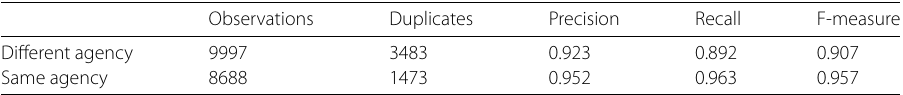
Table 5 Assessment of C5.0 models Observations Duplicates Precision Recall